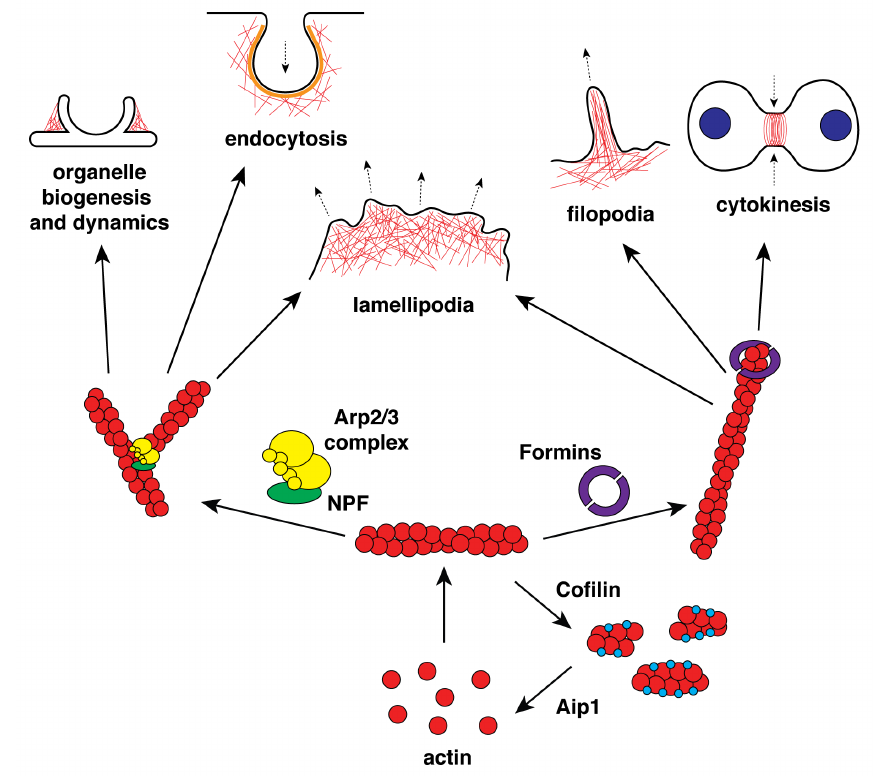
Figure 1. Schematic diagram showing key pathways controlling actin assembly. Aip1, actin-interacting protein 1; Arp2/3, actin-related protein 2/3; NPF, nucleation-promoting